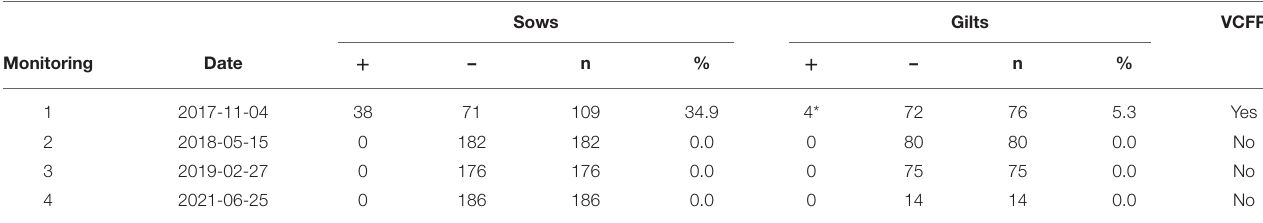
TABLE 1 | Number of serological tests monitoring, dates, number of sows and gilts positive and negative to ADV, totally tested and percentage of positive pigs, and viral circulation IN finishing pigs (VCFP).